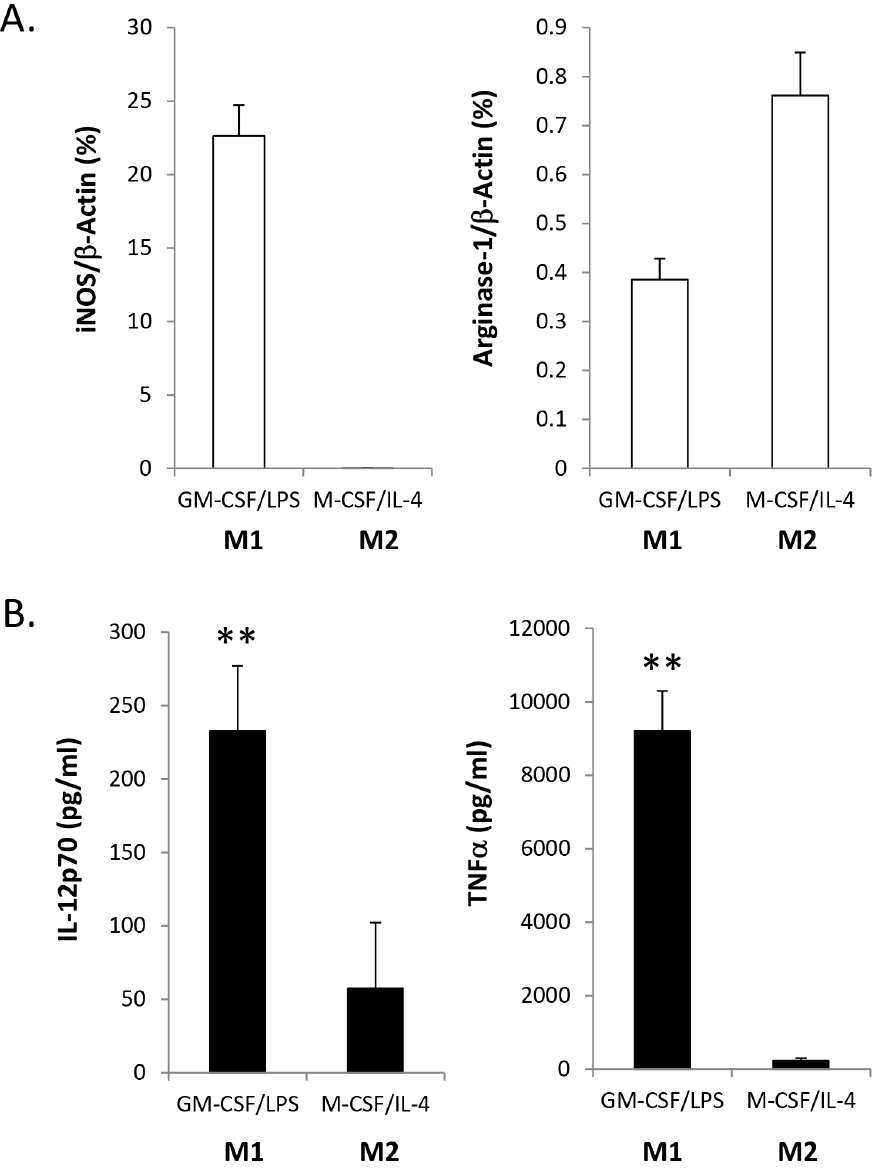
Figure 1. M1 and M2 gene expression in macrophages. Mouse bone marrow cells from C57/black mice were differentiated using 10 ng/ml GM-CSF and 10 ng/ml (each) of M-CSF/IL-4 for M1 and M2 macrophages, respectively for 7 days prior to overnight stimulation with or without LPS (10 ng/ml). A. Lysed cells were used for quantitative real time PCR (RT-qPCR) to quantify gene expression of iNOS and arginase-1 compared with b - actin gene expression. B. The production of TNF a and IL-12p70 was examined by ELISA. The results are representative of three independent experiments.